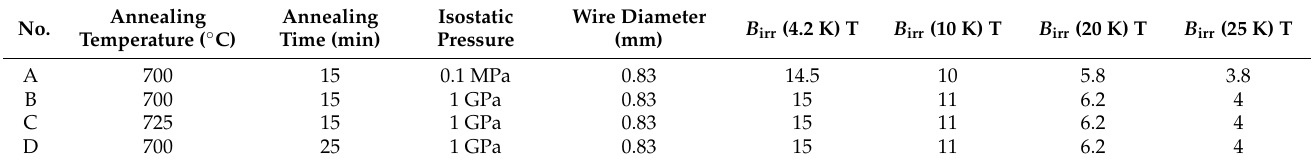
Table 1. Heat treatment parameters of the undoped MgB 2 superconductor wires.